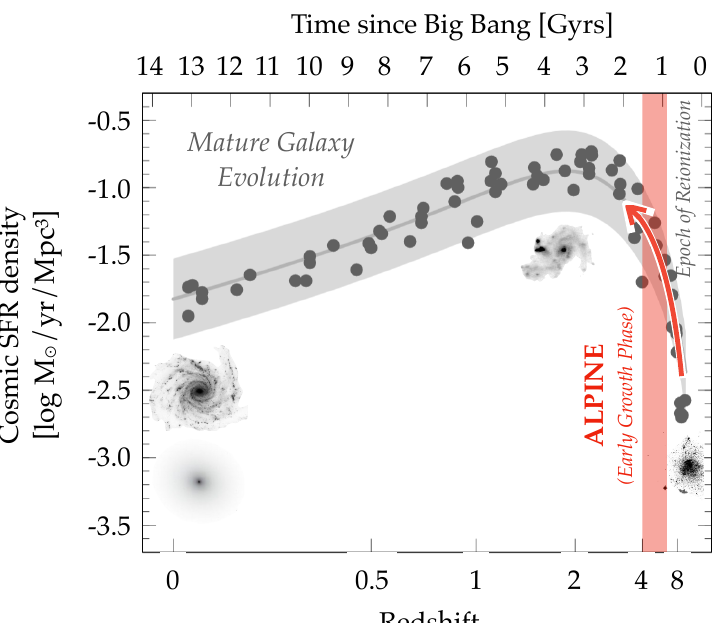
Figure 1. Cosmic SFR density as a function of cosmic time and redshift. The global SFR density increases sharply during primordial galaxy assembly and evolution to reach a peak at z ∼ 2–3 followed by a decline due to the emergence of quiescent galaxies during the mature galaxy evolution. The ALPINE survey (presented in Béthermin et al. [25], Faisst et al. [26], and Le Fèvre et al. [27]) studies galaxy evolution during the Early Growth Phase at z = 4–6, an important connection between primordial and mature galaxy evolution, via a large multiwavelength sample. ALPINE builds the basis for more detailed measurements with the next generation of telescopes, and places itself as an important post-reionization baseline sample to allow a continuous study of galaxies over 13 billion years of cosmic time. The grayscale images show the change in structure of the galaxies across cosmic time. Data points from Madau and Dickinson [7] and Bouwens et al.